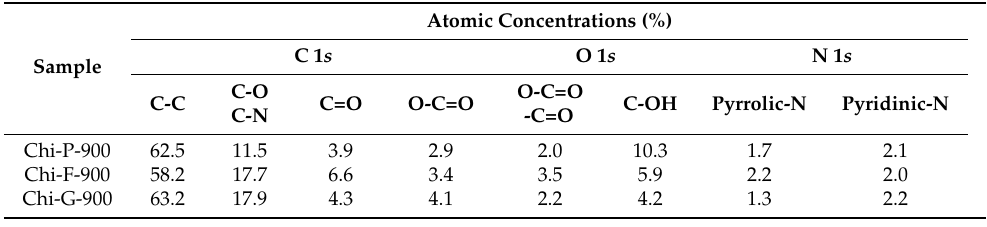
Table 2. Spectral parameters determined by XPS of the biochars obtained after the pyrolytic treatment of chitosans with different textural properties at 900 ◦ C.